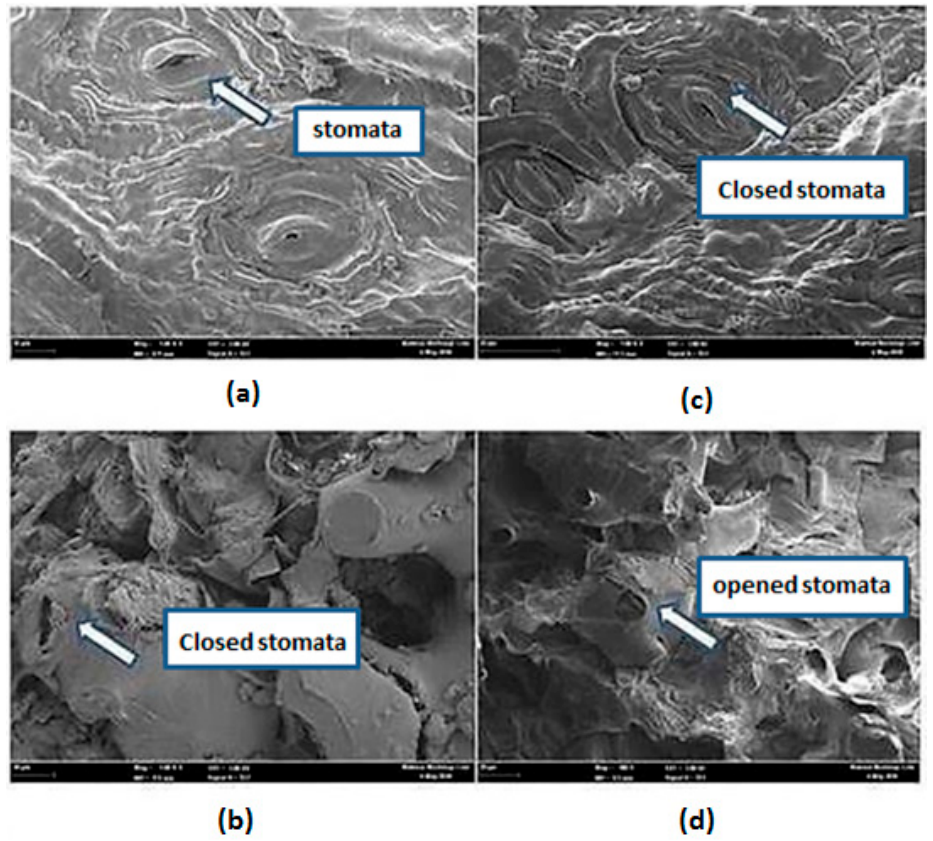
Figure 3. Field-emission Scanning Electron Microscope (FESEM) of the Labisia pumila leaves powder surface ( a ); before extraction (with 1000 × magnification), ( b ) after maceration in 70% ethanol–water (with 1000 × magnification), ( c ) after SC–CO 2 extraction (pure CO 2 ) (with 1000 × magnification), ( d ) after SC–CO 2 extraction using 70% ethanol–water as a co-solvent (with 500 × magnification).